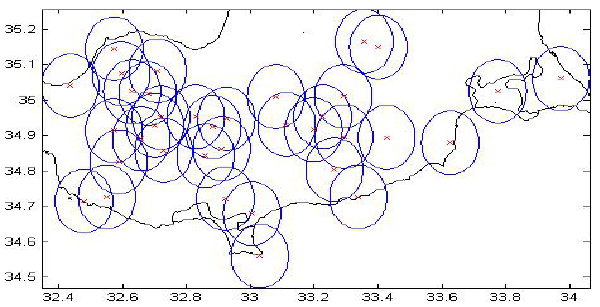
Fig. 2. Lightning data for the event on 18 October 2006.